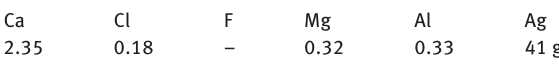
Table 4: Compositions of leached WLR-SD. Elements